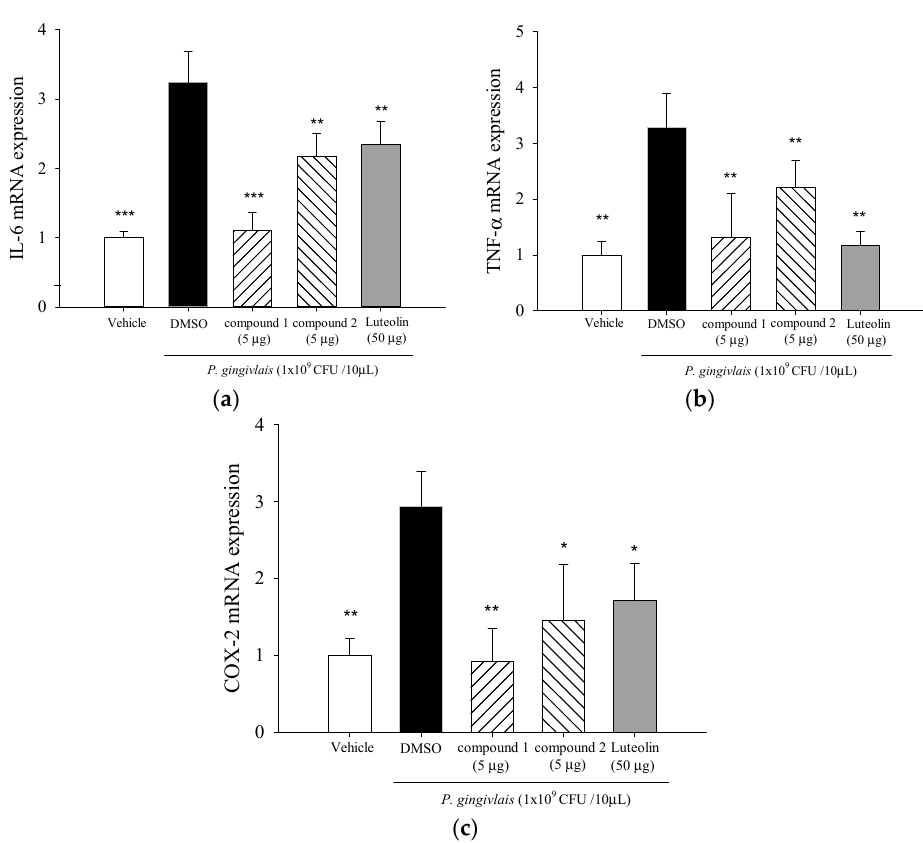
Figure 6. 5 β ,19-epoxycucurbita-6,23-diene-3 β ,19,25-triol ( 1 ) and 3 β ,7 β ,25-trihydroxycucurbita-5,23-dien-19-al ( 2 ) suppressed pro-inflammatory cytokine mRNA expressions in P. gingivalis -stimulated gingival tissue of mice. Each column shows the mean ± SD ( n = 5). * p < 0.05, ** p < 0.01, and *** p < 0.001 vs. DMSO vehicle ( P. gingivalis alone).